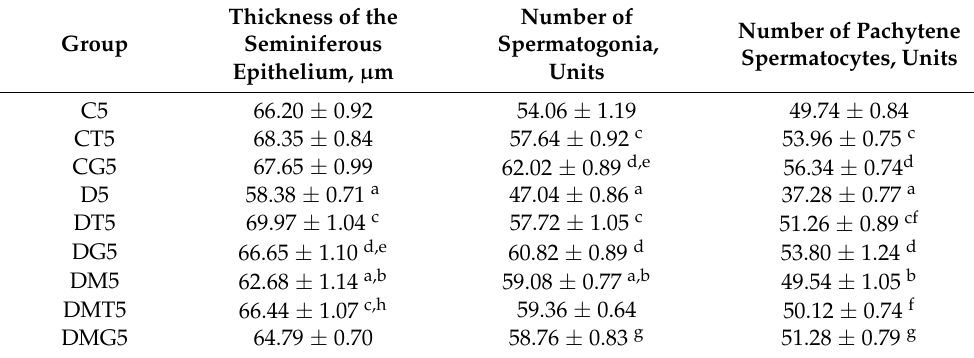
Table 6. The effects of five-week metformin treatment, five-day treatment with LH/hCG-R-agonists and their combination on thickness of the seminiferous epithelium and the number of spermatogonia and pachytene spermatocytes in the control and diabetic